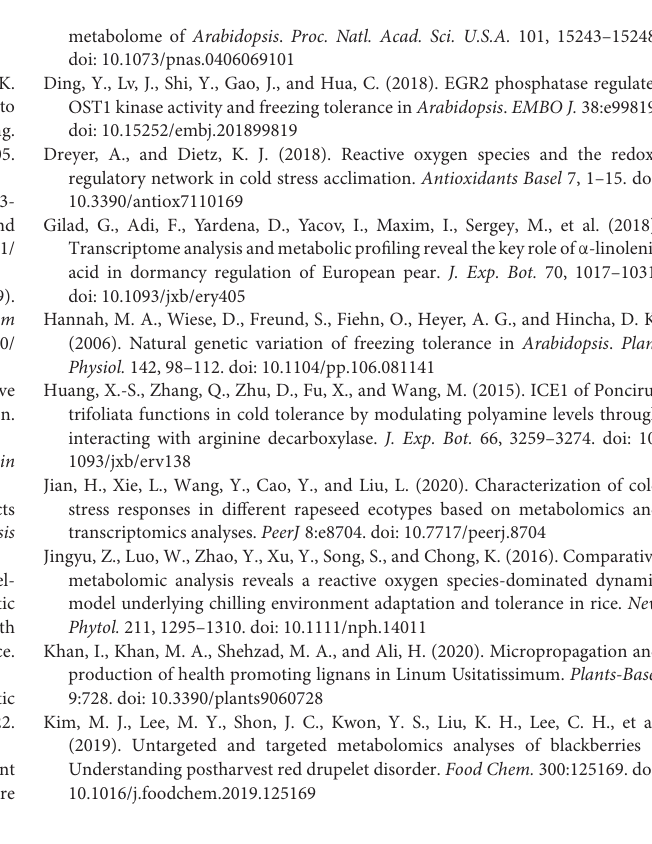
Supplementary Figure 1 | Overview and analysis of the transcriptome. ( a ) Distribution of transcripts sequence length. ( b ) Unigenes were annotated in 7 databases. ( c ) Unigenes were annotated in Nr database and species distribution statistics. ( d ) Unigenes were annotated in GO and classified into Biological process, Cellular component and Molecular Function. ( e ) Unigenes were annotated in KOG and classified into different function. ( f ) Pearson’s correlation coefficient analysis in different samples. Supplementary Figure 2 | Summary of differential expression analysis of kiwifruit under cold stress. Supplementary Figure 3 | Overview of DEGs in RB-0 h VS. KL-0 h. ( a ) The volcano plot between the RB-0 h and KL-0 h. ( b ) Enrichment of DEGs in the KEGG pathway. Supplementary Table 1 | The statistical results of clean reads mapped into reference. Supplementary Table 2 | Common responding metabolites lipids in KL and RB. Supplementary Table 3 | Flavonoids that specifically accumulated in KL. Supplementary Table 4 | Phenolic acids specific accumulated in RB. Supplementary Table 5 | Nucleotides specific accumulated in